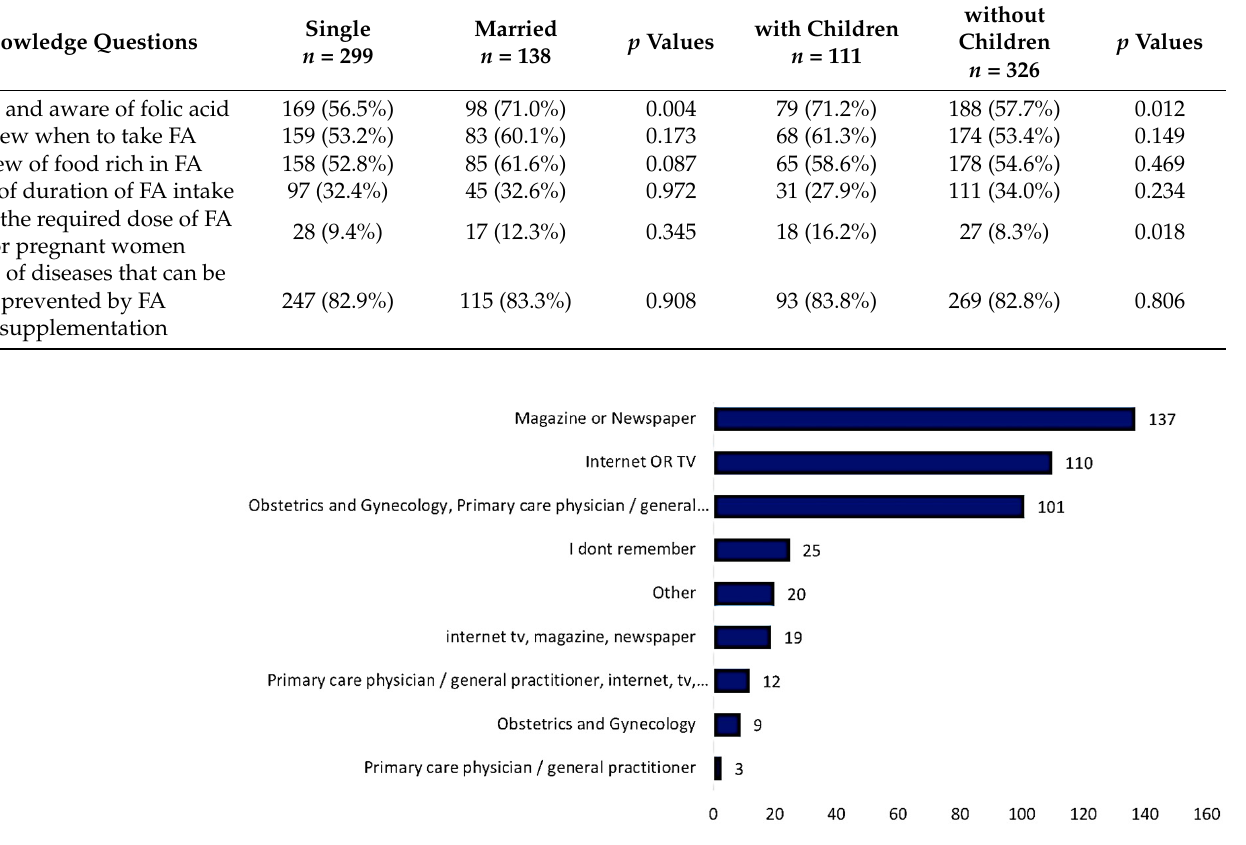
Figure 1. Sources of information about FA and FA supplementation.